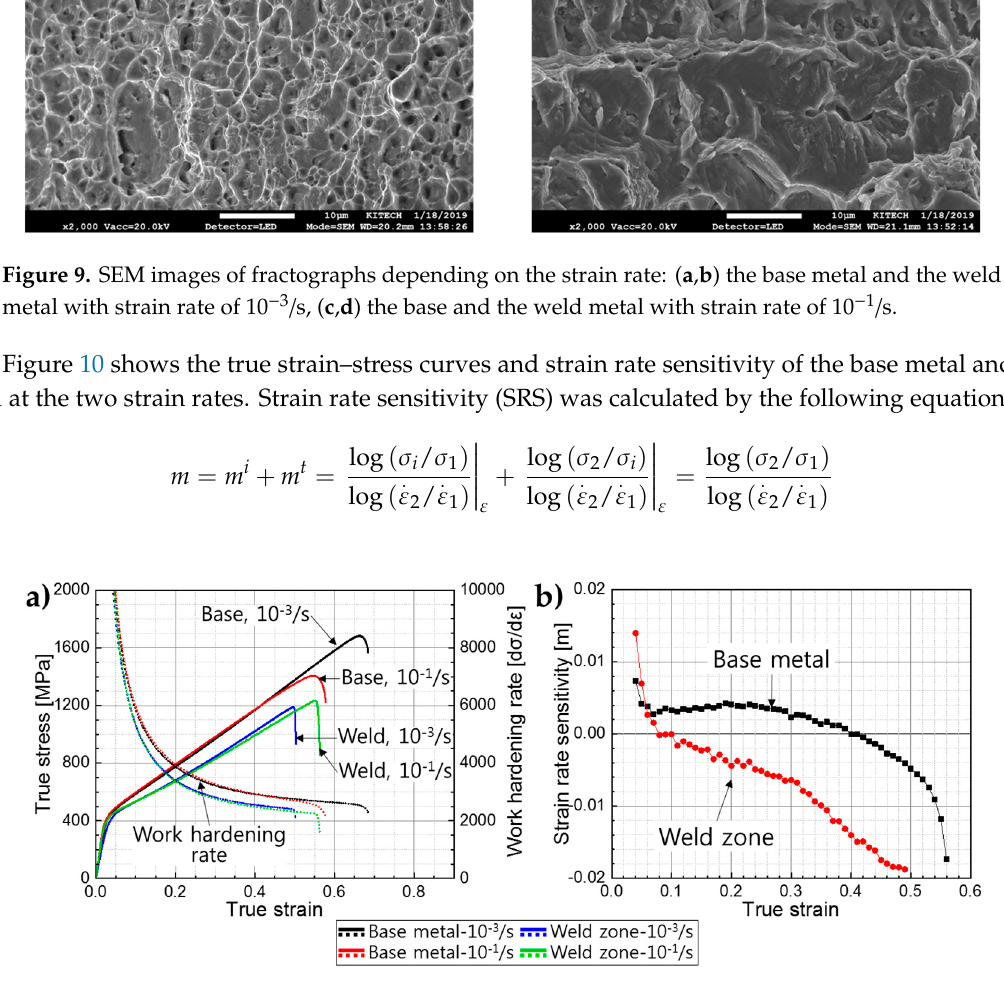
Figure 10. ( a ) True strain–stress curves and ( b ) strain rate sensitivity parameters calculated from the true strain–stress curves (strain rate of 10 − 3 /s to 10 − 1 /s).